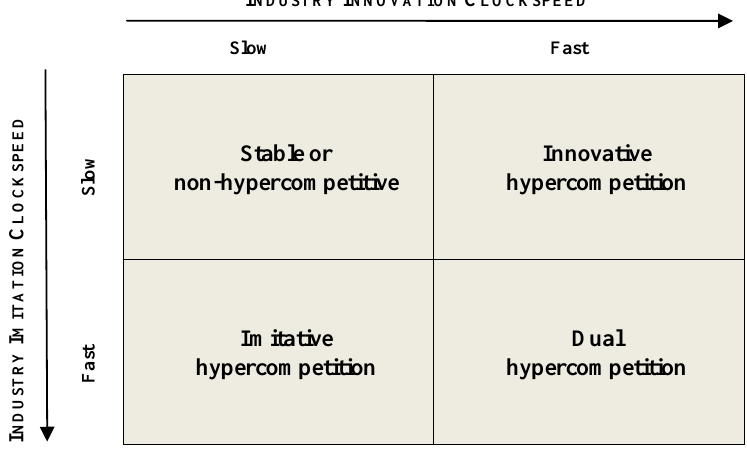
Figure 1 : Hypercompetition Based on Innovation and Imitation Clockspeed